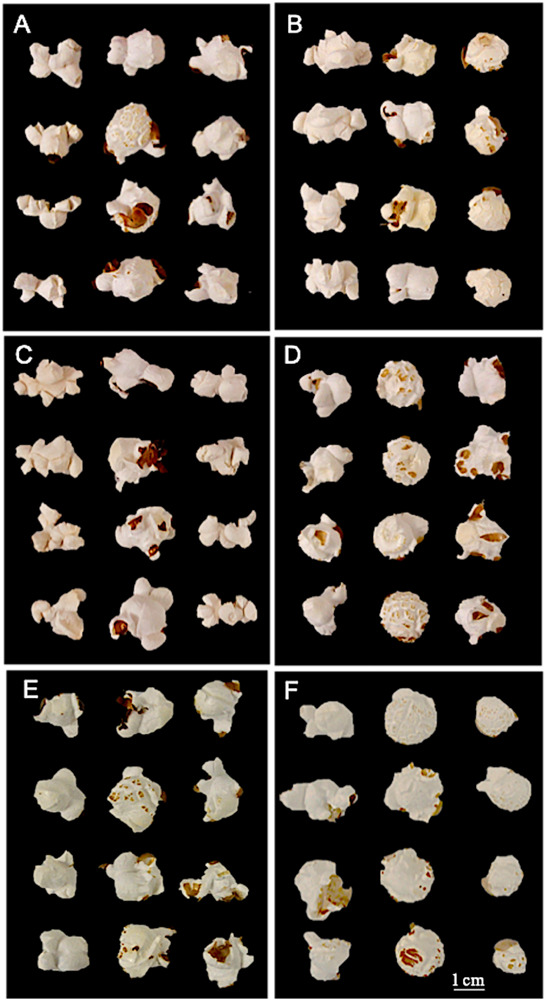
Inbred and hybrid flake morphology. (A) First column: maternal parent 6 (bilateral morphology); Second column: Hybrid 20; Third column: paternal parent 10. (B) First column: maternal parent 9; Second column: Hybrid 25 (unilateral morphology); Third column: paternal parent 3. (C) First column: maternal parent 9; Second column: Hybrid 28 (multilateral morphology); Third column: paternal parent 6. (D) First column: maternal parent 10; Second column: Hybrid 34 (mushroom morphology); Third column: paternal parent 1. (E) First column: maternal parent 10; Second column: Hybrid 38; Third column: paternal parent 5. (F) First column: maternal parent 10; Second column: Hybrid 43; Third column: paternal parent 11.